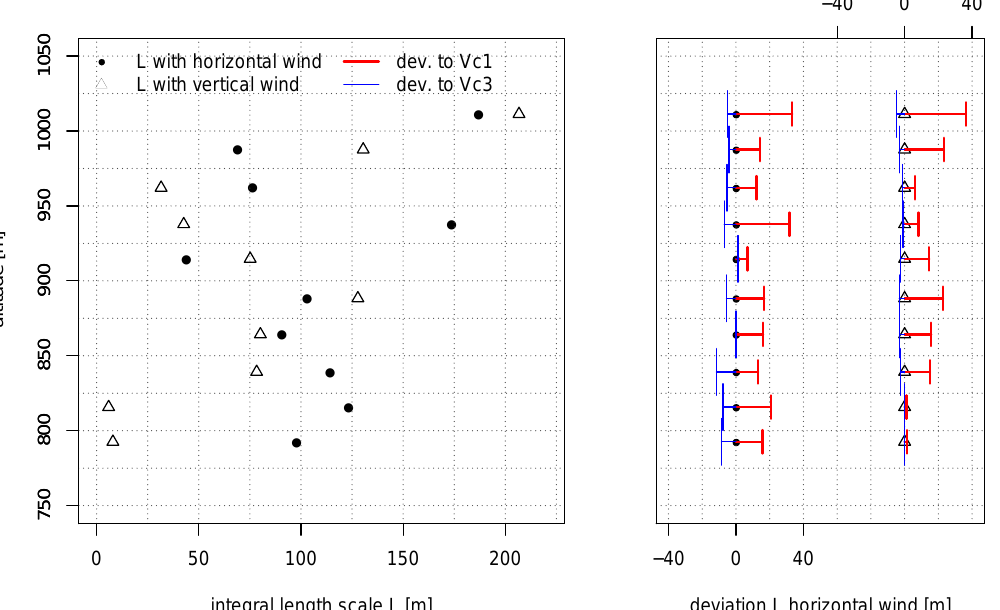
Figure 13. Height profiles of the COMPLEX flight with the altitude AMSL of the integral length scale of the horizontal windspeed L ( v h ) and the vertical windspeed L ( w ) , calculated with the calibration polynomial at v c 2 ( left ). Deviations ( right ), when applying the calibration polynomials at v c 1 and v c 3